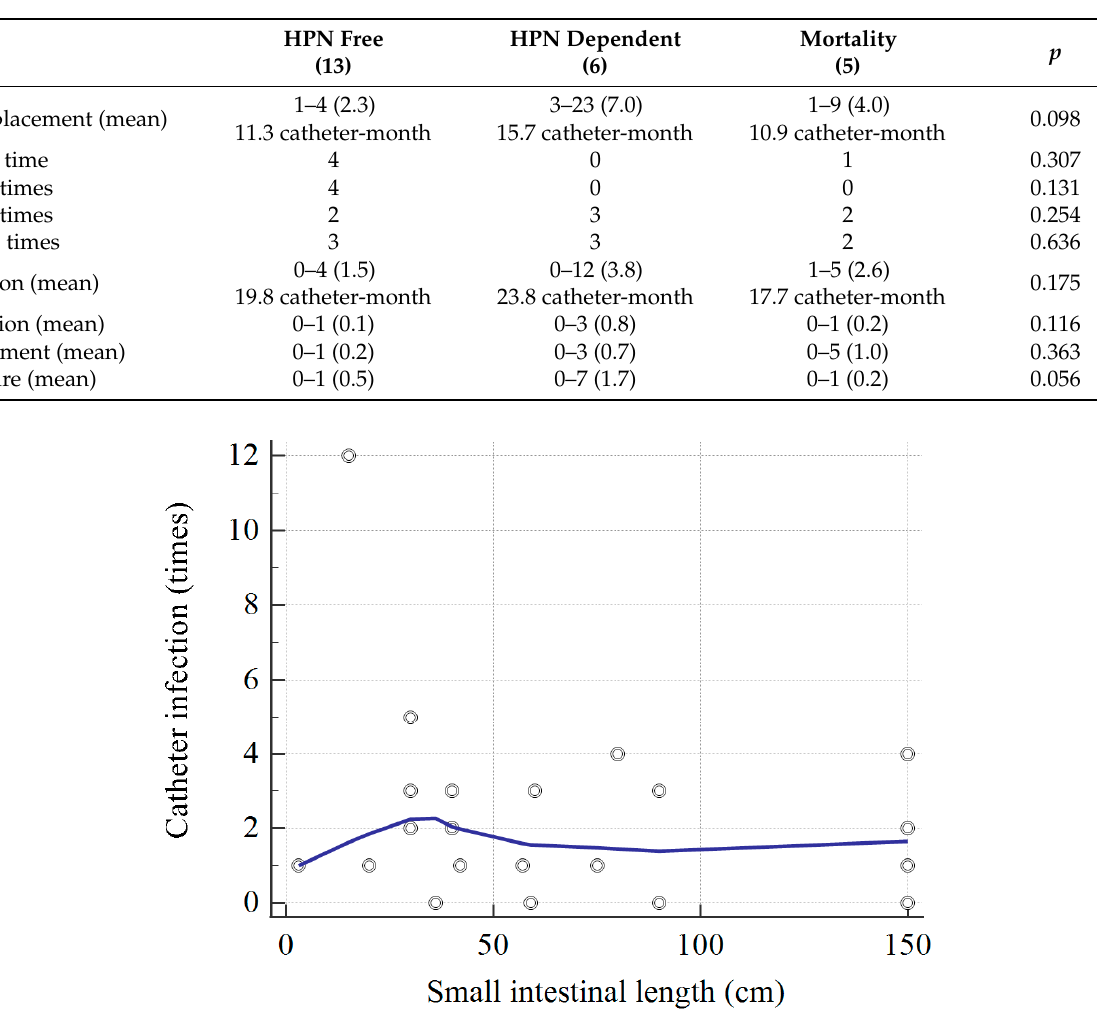
Table 4. Central line catheter-related complications of HPN patients.